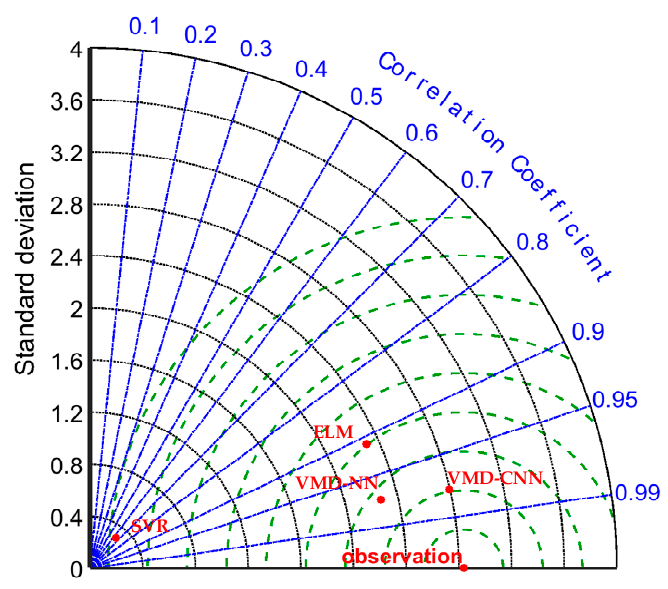
Figure 9. Taylor diagram of testing example 1.